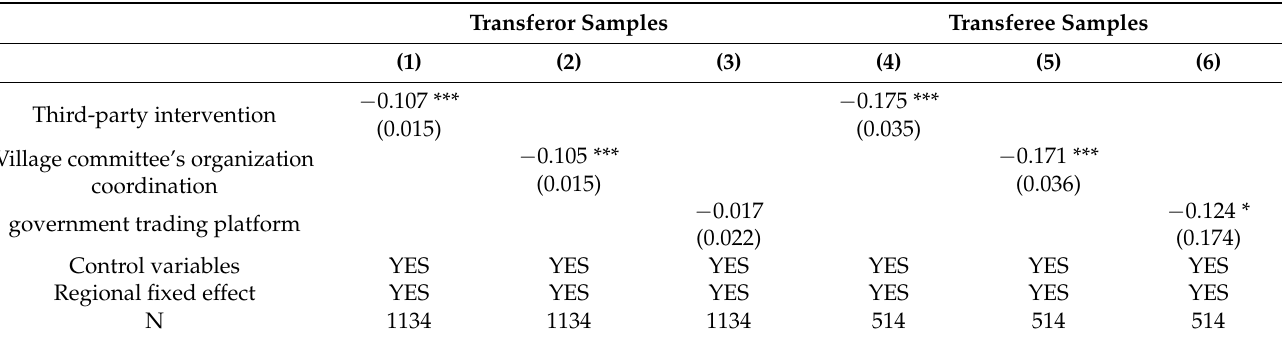
Table 9. Impact of third-party intervention on transfer object